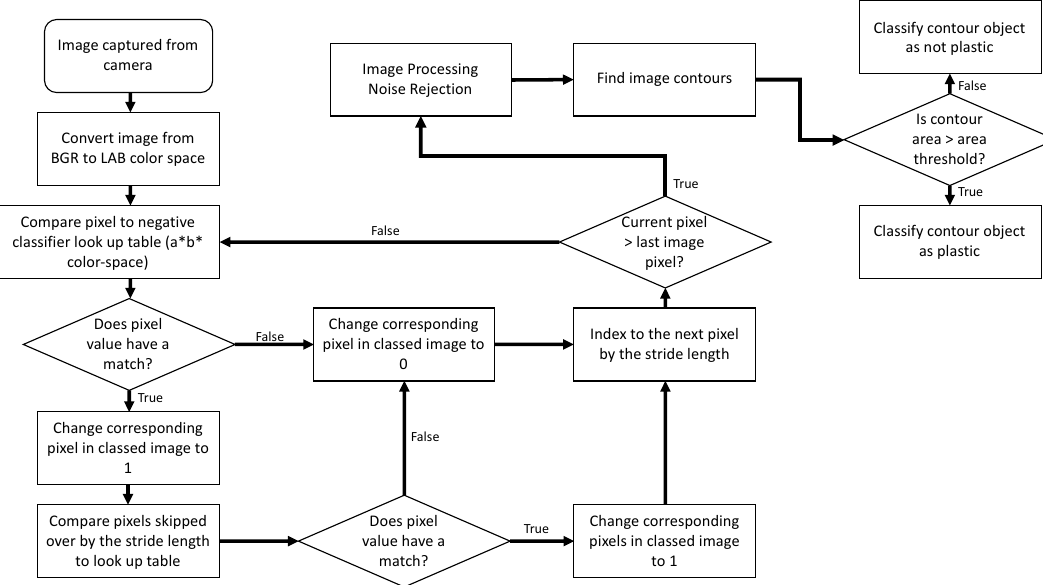
Figure 20. The process to detect plastic in an image showing the methods used to detect plastic in the “cProcess_Lab_Image” class. Image pixels colors are compared to the values stored in the look-up table to build objects of interest in the image. For pixels that are classified as plastic, the surrounding pixels are also analyzed for classification. Once the pixels are finished being classified, contours are defined to outline the objects. The area of the pixels is compared to a set threshold to reduce noise and determine whether plastic is present in the image.